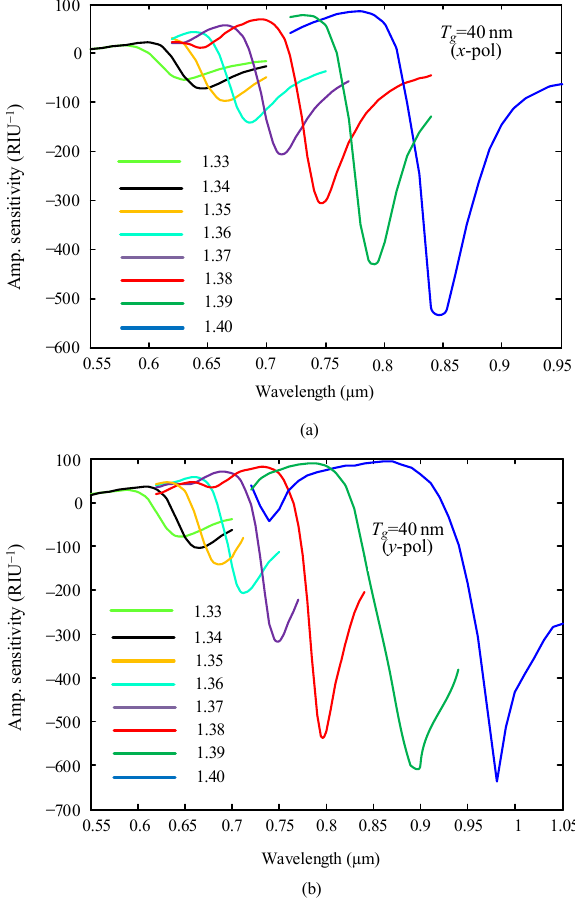
Fig. 6 Amplitude sensitivity as a function of wavelength for different analyte RIs for (a) x - and (b) y -polarized